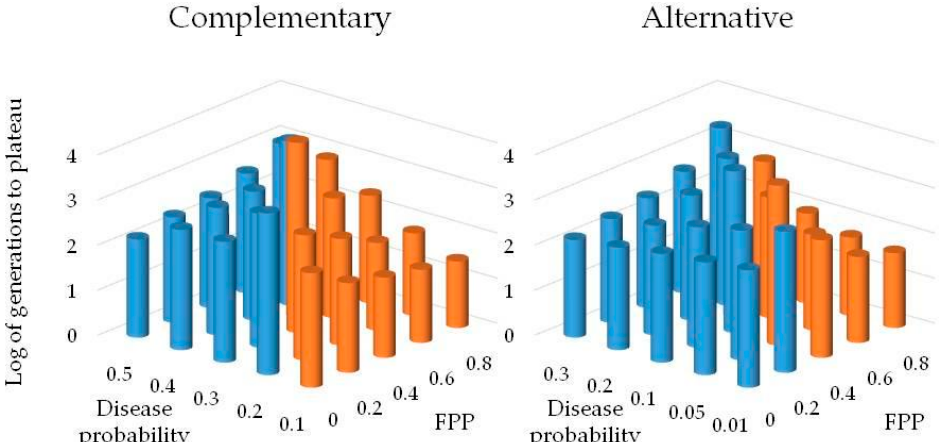
Plants 2019 , 8 , x FOR PEER REVIEW